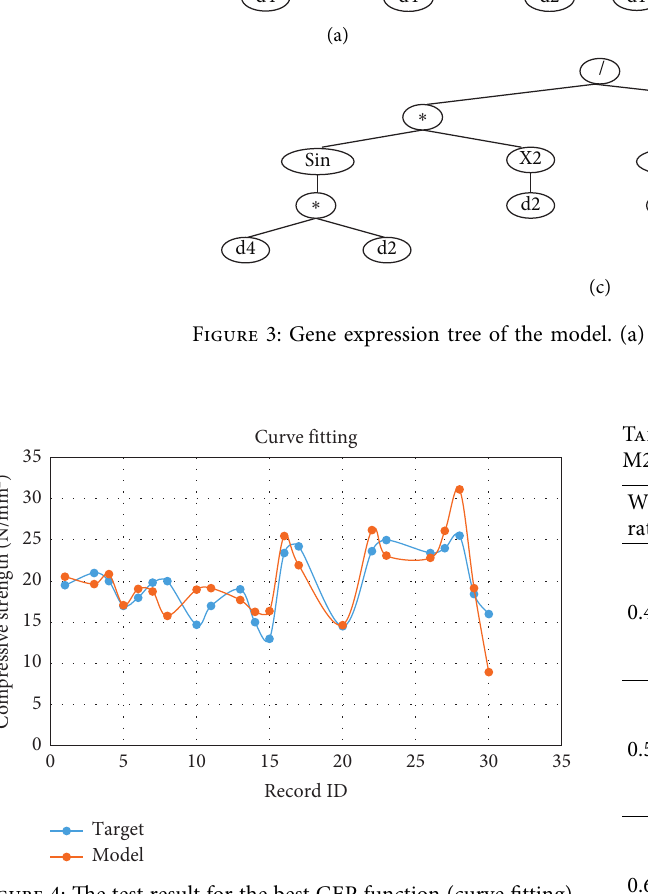
Figure 4: The test result for the best GEP function (curve fitting).